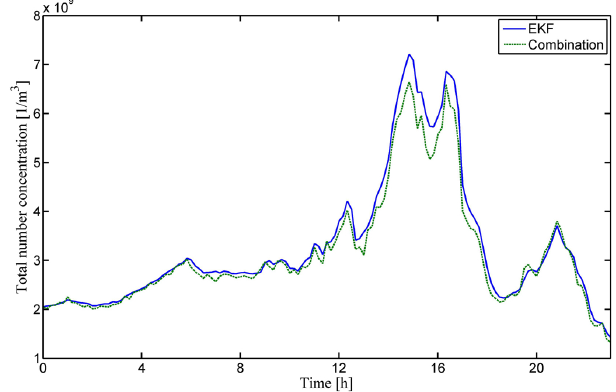
Fig. 1a. Particle number size distribution obtained with EKF using Fig. 1c. The total number concentrations for particles larger than ) on 7 May 2007 from SMEAR DMPS and APS observations ( x N DA 3nm for x N (blue, solid) and x N com (green, II in Hyyti¨al¨a, Finland. Note that the particle number concentrations DA are only presented from 10 2 to 10 9 m − 3 . The color bar values are given as exponents of 10.